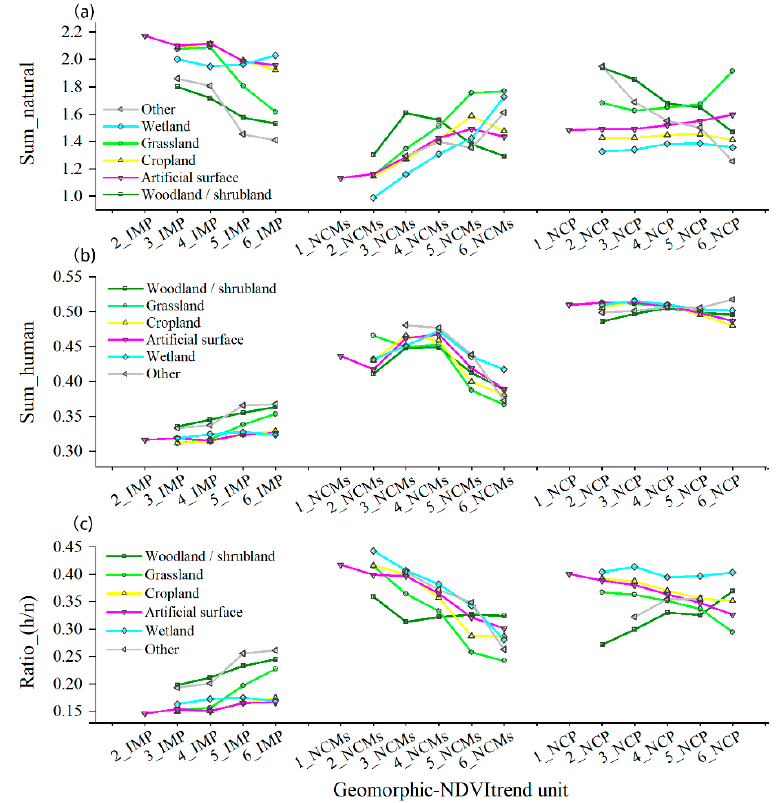
Figure 5. ( a ) Sum of natural variables of different land cover types in each geomorphic-NDVItrend unit. ( b ) Sum of human variables of different land cover types in each geomorphic-NDVItrend unit. ( c ) Ratio of human to natural factors of different land cover types in each geomorphic-NDVItrend unit. The geomorphic-NDVItrend unit represents different NDVI trends in the primary geomorphic units, 1_ to 6_ represents NDVI-ESD to NDVI-ESI, IMP represents the Inner Mongolia Plateau, NCMs represents the North China Mountains, and NCP represents the North China Plain.